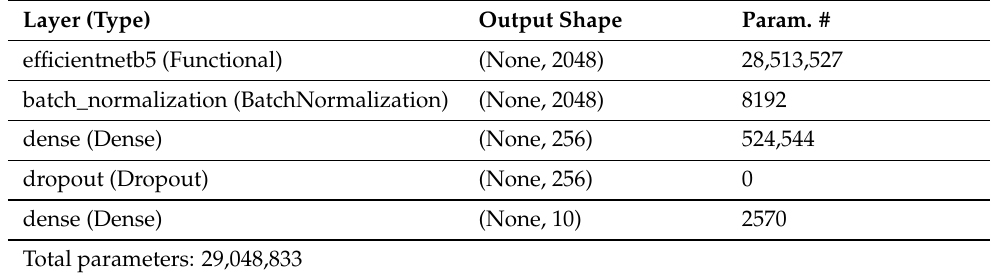
Table 1. Summary for the proposed model. Note that “Param. #” denotes the number of parameters in the respective